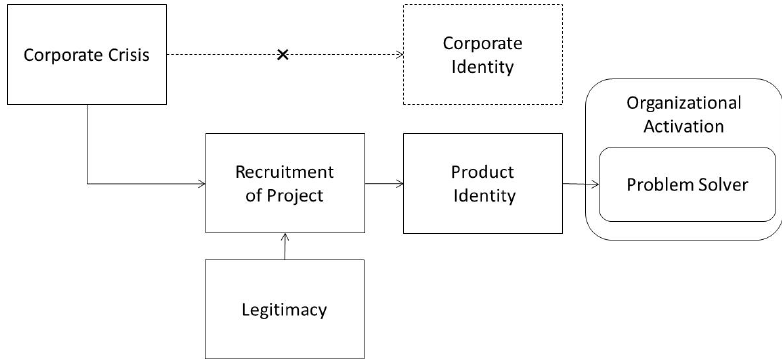
Figure 3. Path to organizational